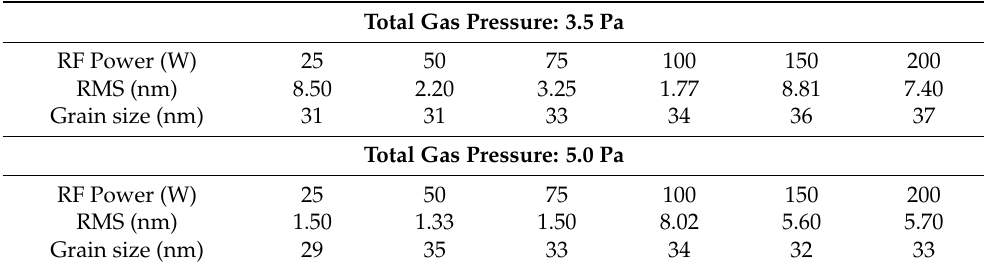
Table 3. Surface roughness RMS and grain size calculated from AFM 1 × 1 µ m 2 images of the Cu 3 N films fabricated on glass by RF magnetron sputtering in a pure nitrogen atmosphere.